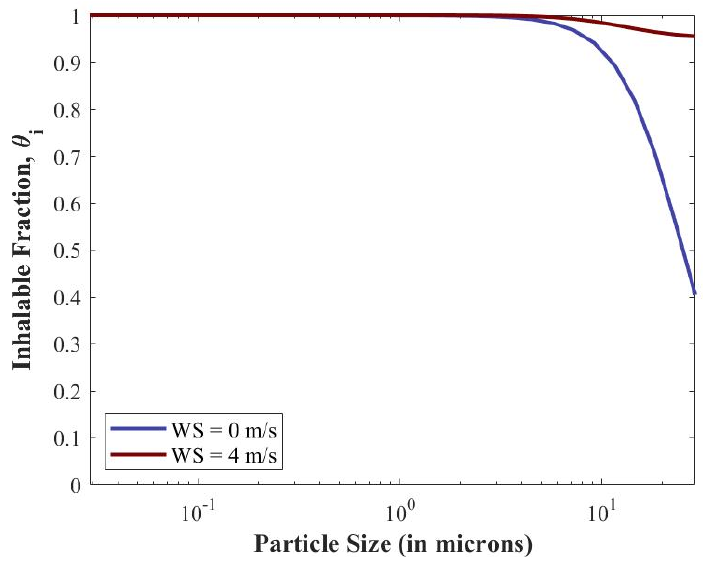
Figure 6 . Inhalable fractions ( 𝜃 𝑖 ) for varying particle sizes ( 𝑑 𝑖